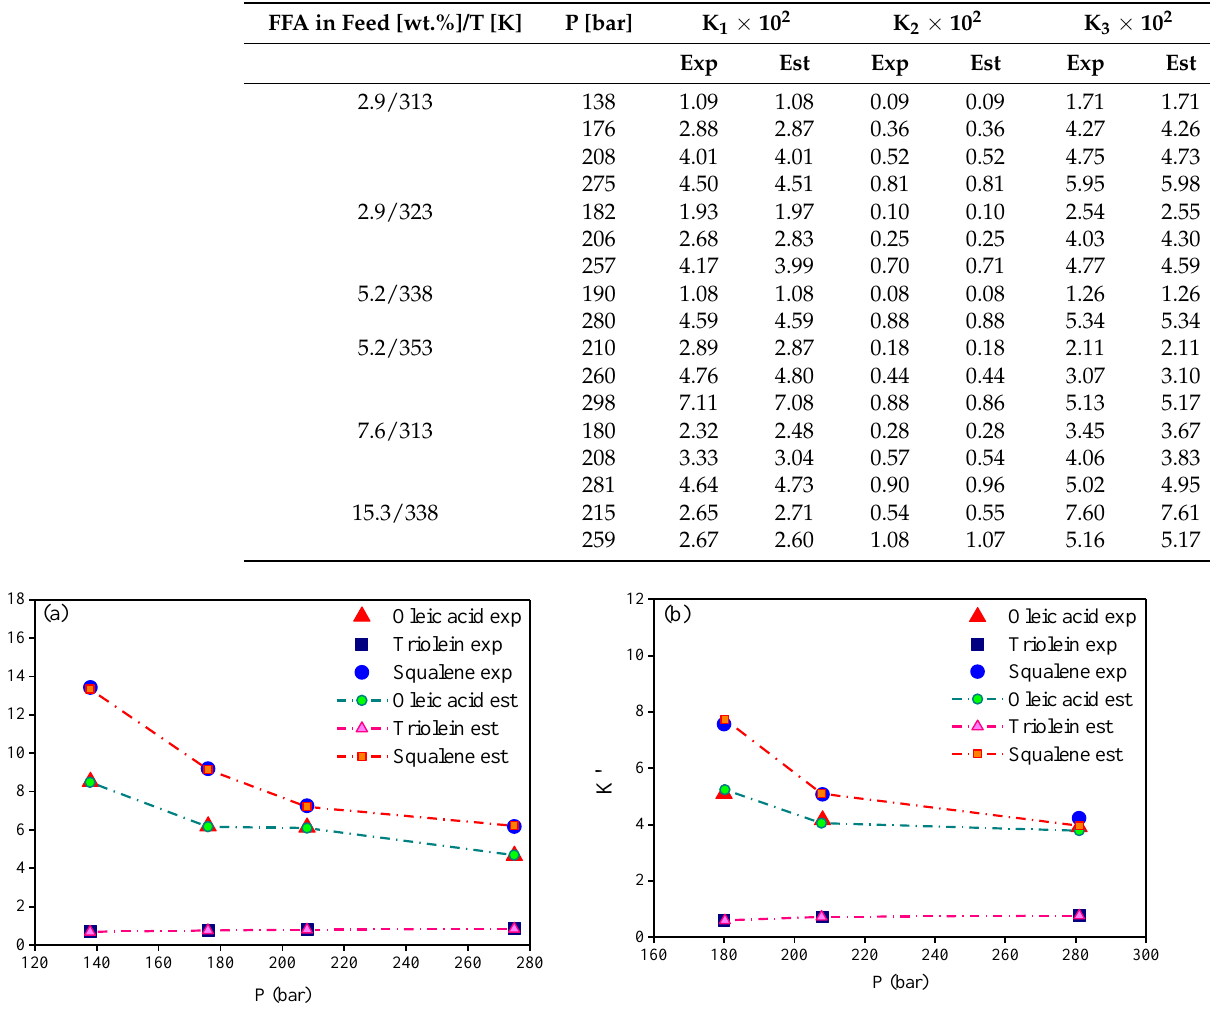
Figure 5. Experimental and estimated distribution coefficients K i , expressed in CO 2 -free basis, at 313 K with ( a ) 2.9 and ( b ) 7.6 [wt.%] of FFA.